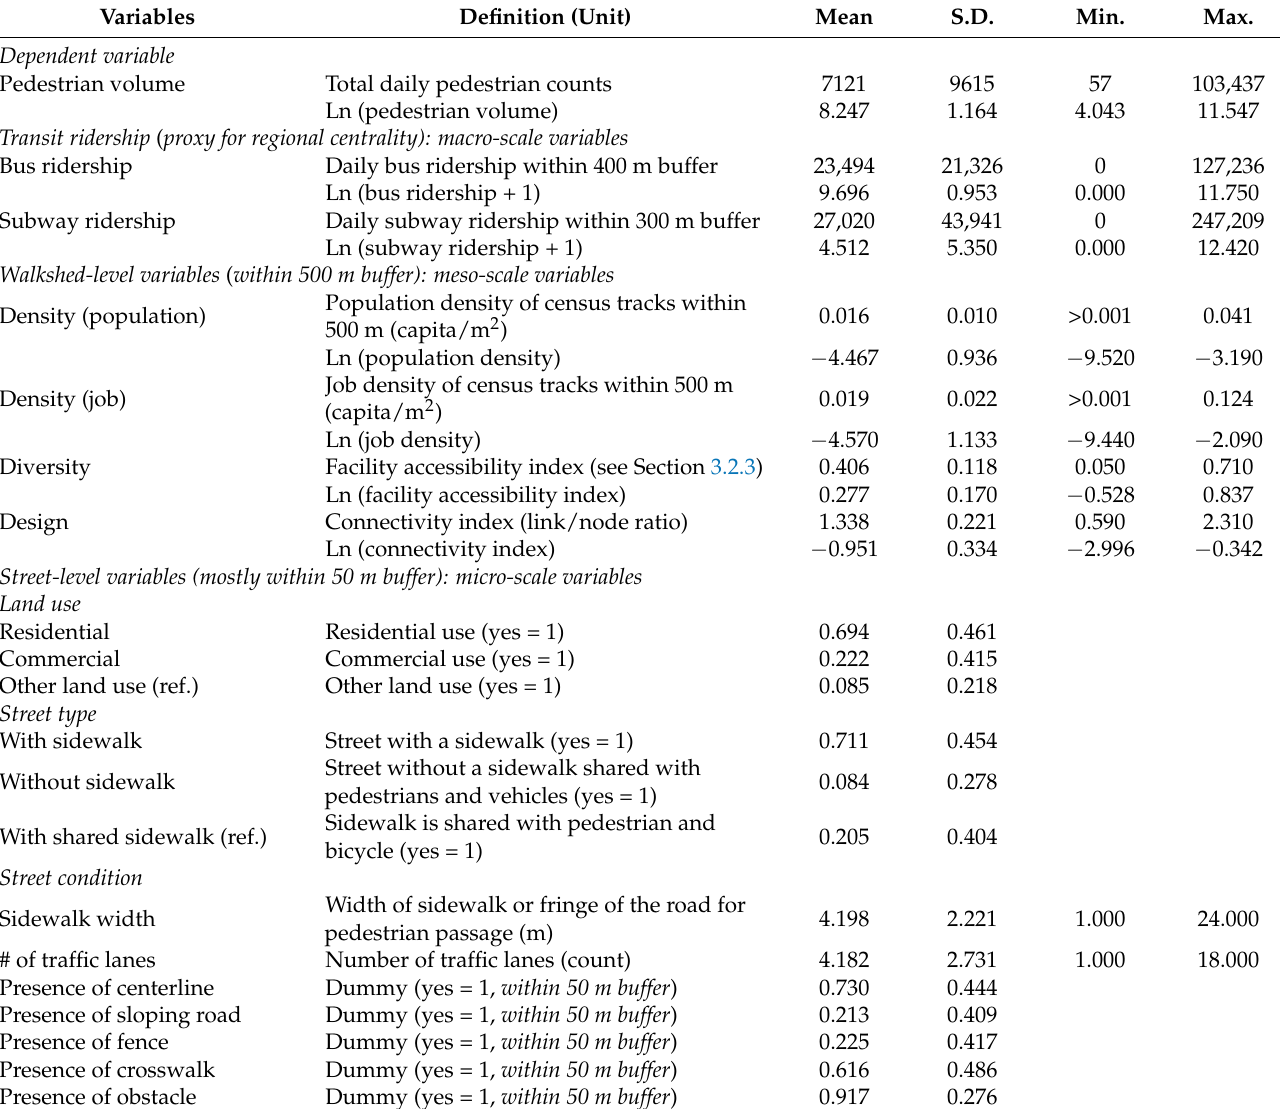
Table 2. Definitions and descriptive